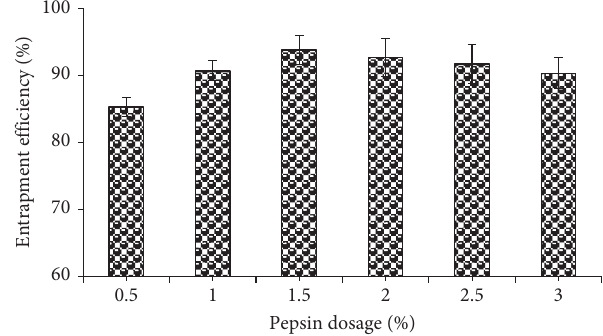
Figure 2: Effect of pepsin dosage on entrapment efficiency of lutein. The other hydrolysis conditions were kept constant: hy- drolysis temperature 50 ° C, pH 3.0, and hydrolysis time 4h. Data were expressed as mean values ± standard deviation ( n � 3).